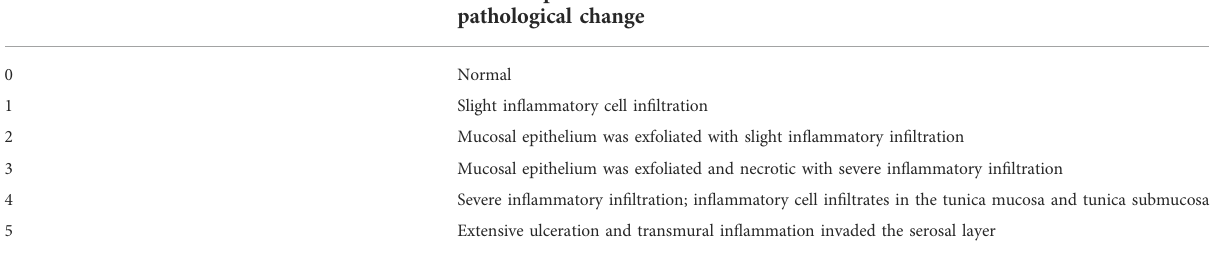
TABLE 3 Colon damage index scoring